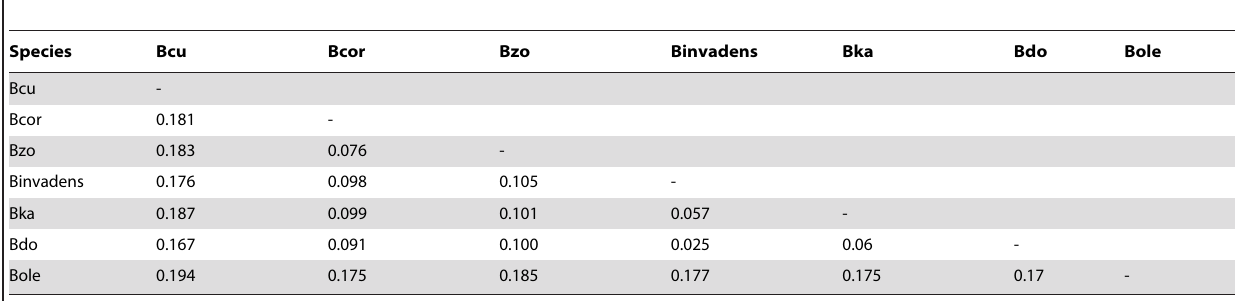
Table 4. Estimates of Evolutionary Divergence over Sequence Pairs between Groups generated by Mega 5 program (Tamura et al. , 2011).